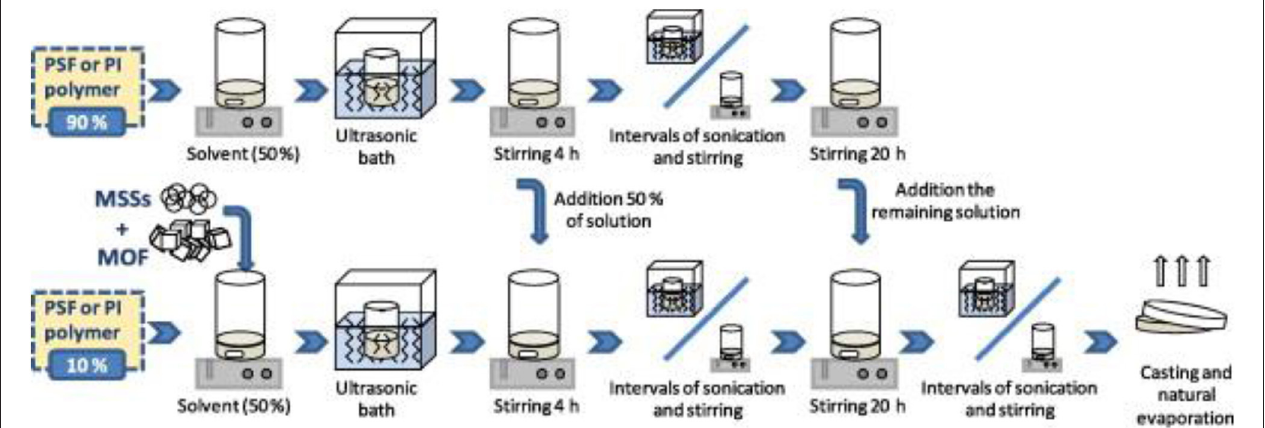
FIGURE 8 | Mixed matrix membrane (MMM) preparation protocol for the merging of two inorganic phases. Reproduced from Valero et al. (2014). Copyright obtained from Elsevier (license number 4681851284675).